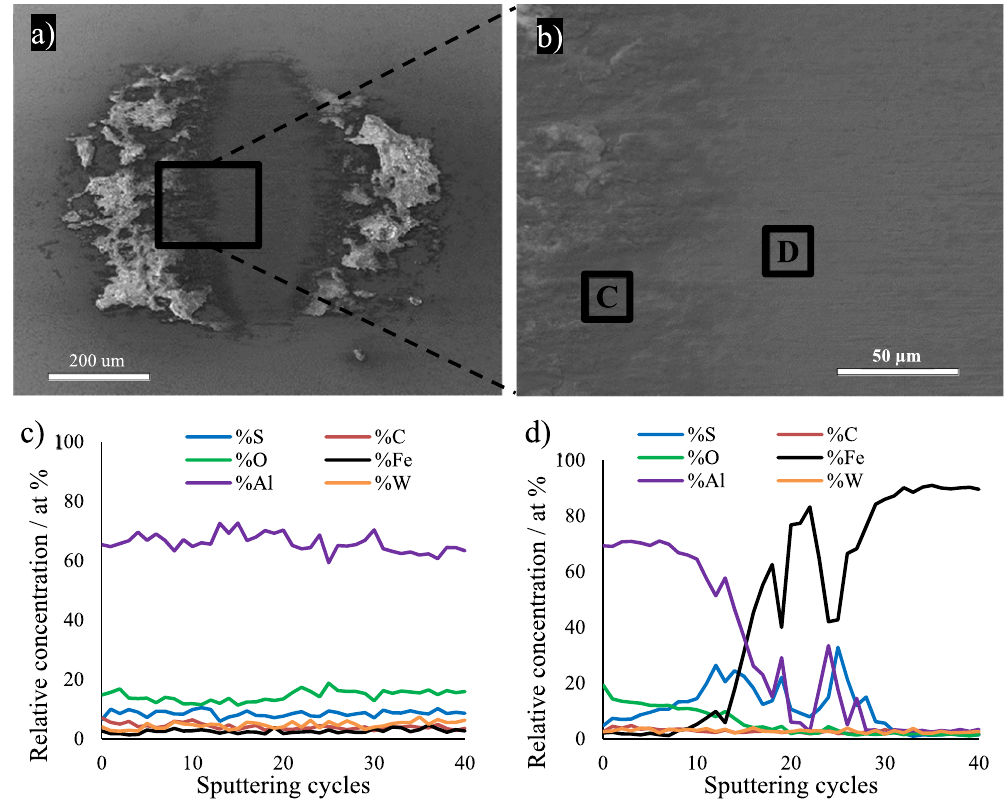
Figure 14. ( a , b ) SEM images of the wear scar on the ball tested against the 2H-WS 2 composite at 100 °C; ( c , d ) Auger ion sputtering depth profile of the chemical composition in points C and D of the tribofilm.